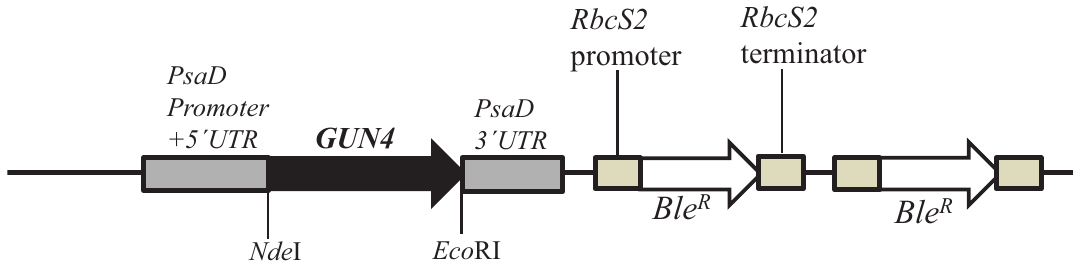
Figure 8. A schematic figure of the pDBle vector used for complementation of gun4-II . Nde I/ Eco RI double digested GUN4 gene (956 bp) was cloned into the Nde I/ Eco RI double digested pDBle plasmid. Primers used for amplification of the GUN4 gene are shown in Table 5. GUN4 expression is driven by the constitutive PsaD promoter. Nde I and Eco RI restriction sites are labeled. pDBle contains two copies of Ble R genes driven by the Rubisco ( RbcS2 ) promoter. The size of the GUN4 - pDBle construct is 7653 bp. The black arrow and the white arrow, denotes GUN4 and Ble R genes, respectively. Grey and tan boxes denote UnTranslated Regions